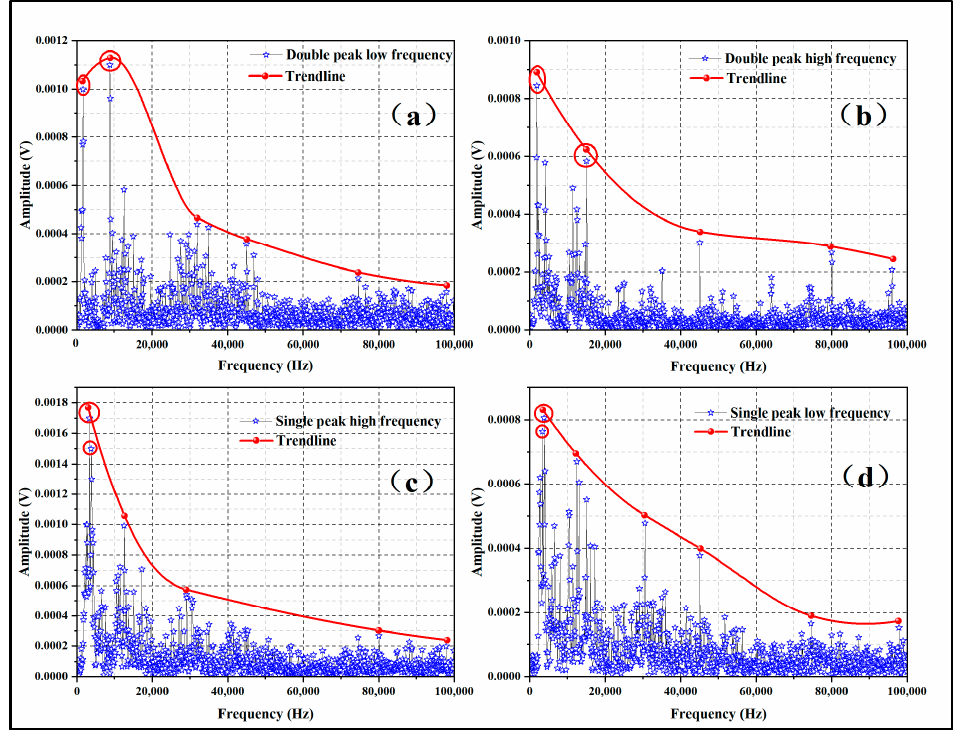
Figure 7. Spectrograms of four typical power articles. ( a ) double peak low frequency; ( b ) double peak high frequency; ( c ) single peak high frequency; ( d ) single peak low frequency.